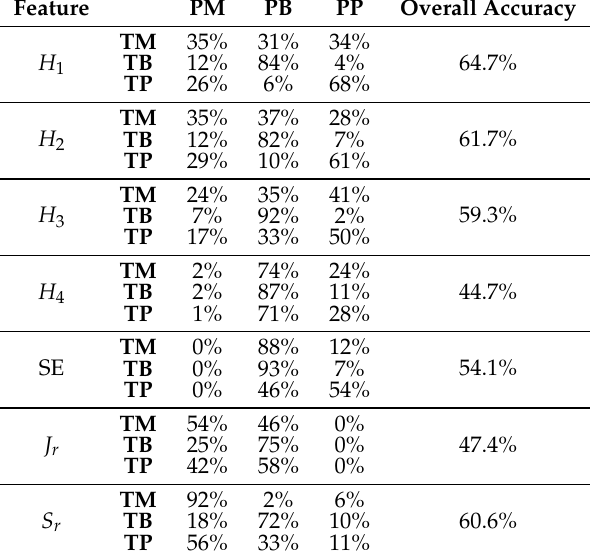
Table 1. Confusion matrix and overall accuracy in voice type classification using a single